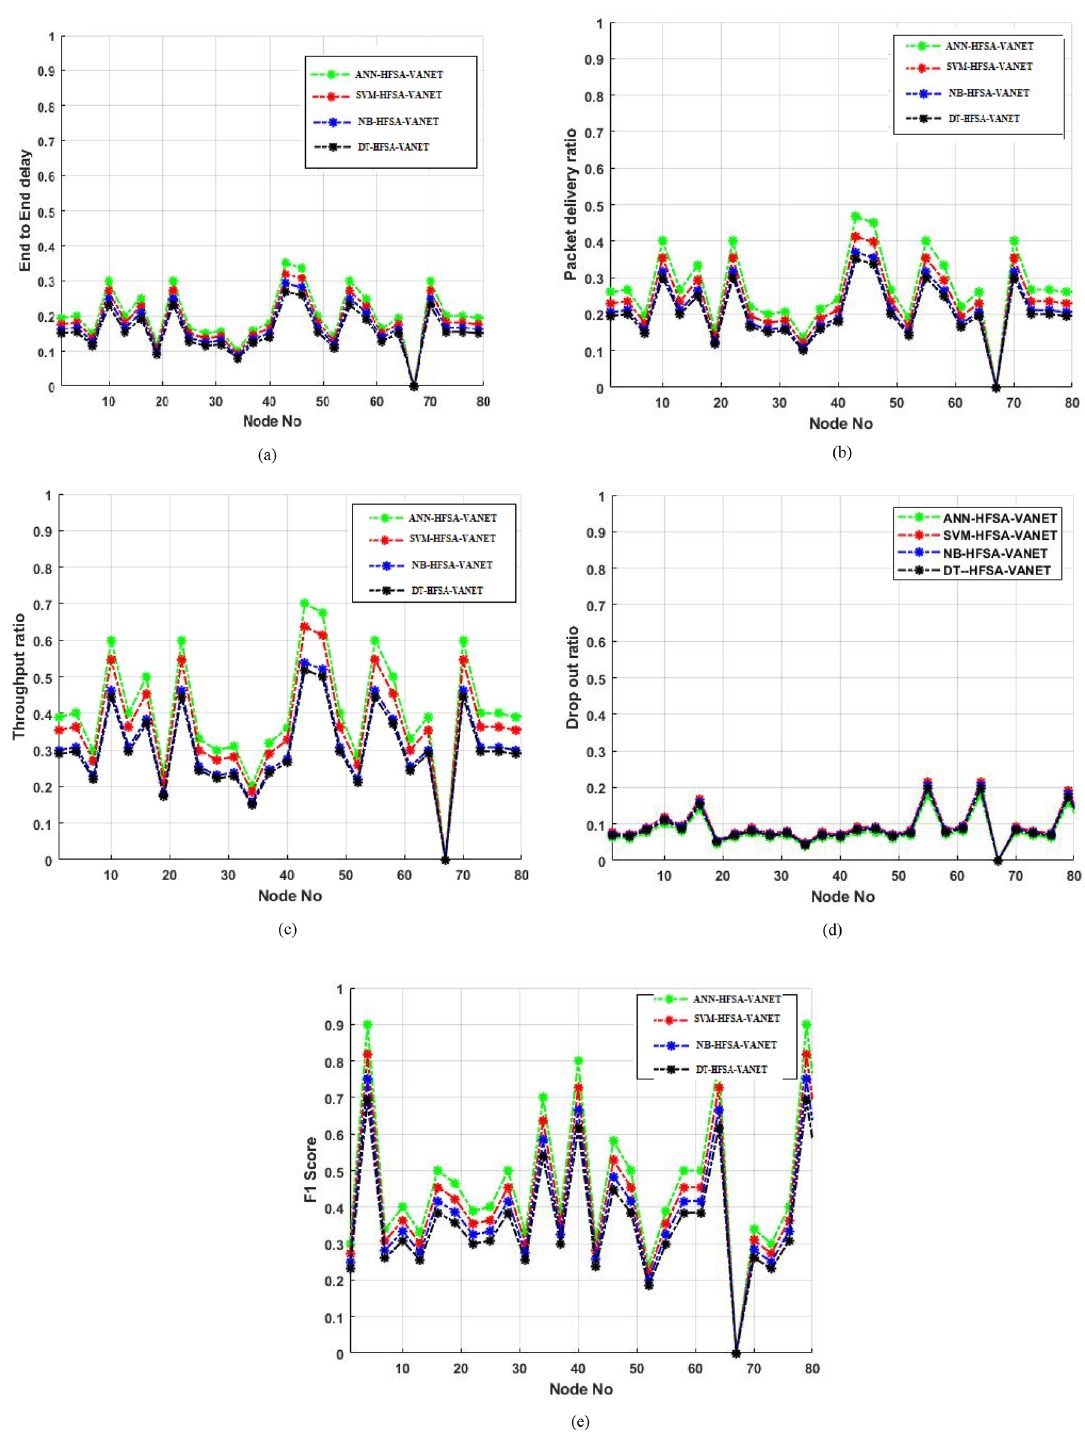
Figure 18. Comparison of algorithms using parameters ( a ) End to End delay, ( b ) Packet delivery ratio, ( c ) Throughput ratio, ( d ) Drop out ratio, ( e ) F1